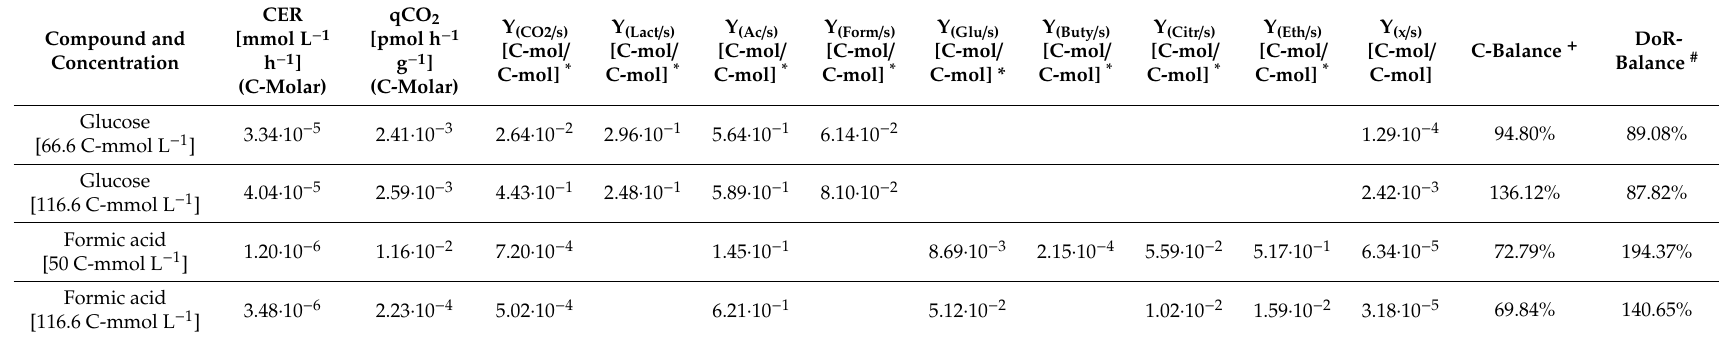
Table 2. Productivity and yields of D. amylolyticus from glucose or formic acid metabolisation during closed batch end-point experiments. Compound and